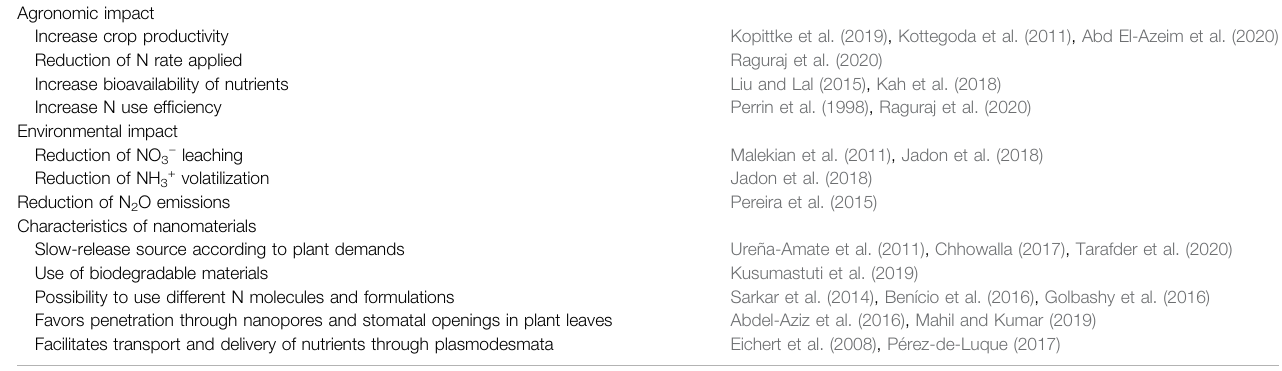
TABLE 1 | Potential advantages of nanofertilizers as an alternative to increasing nitrogen use ef fi ciency.